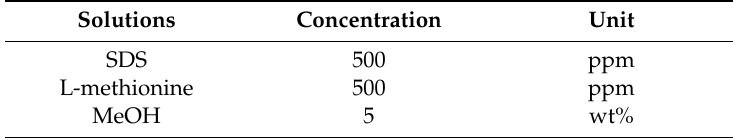
Table 1. Chemical types and respective concentrations used in experiments.